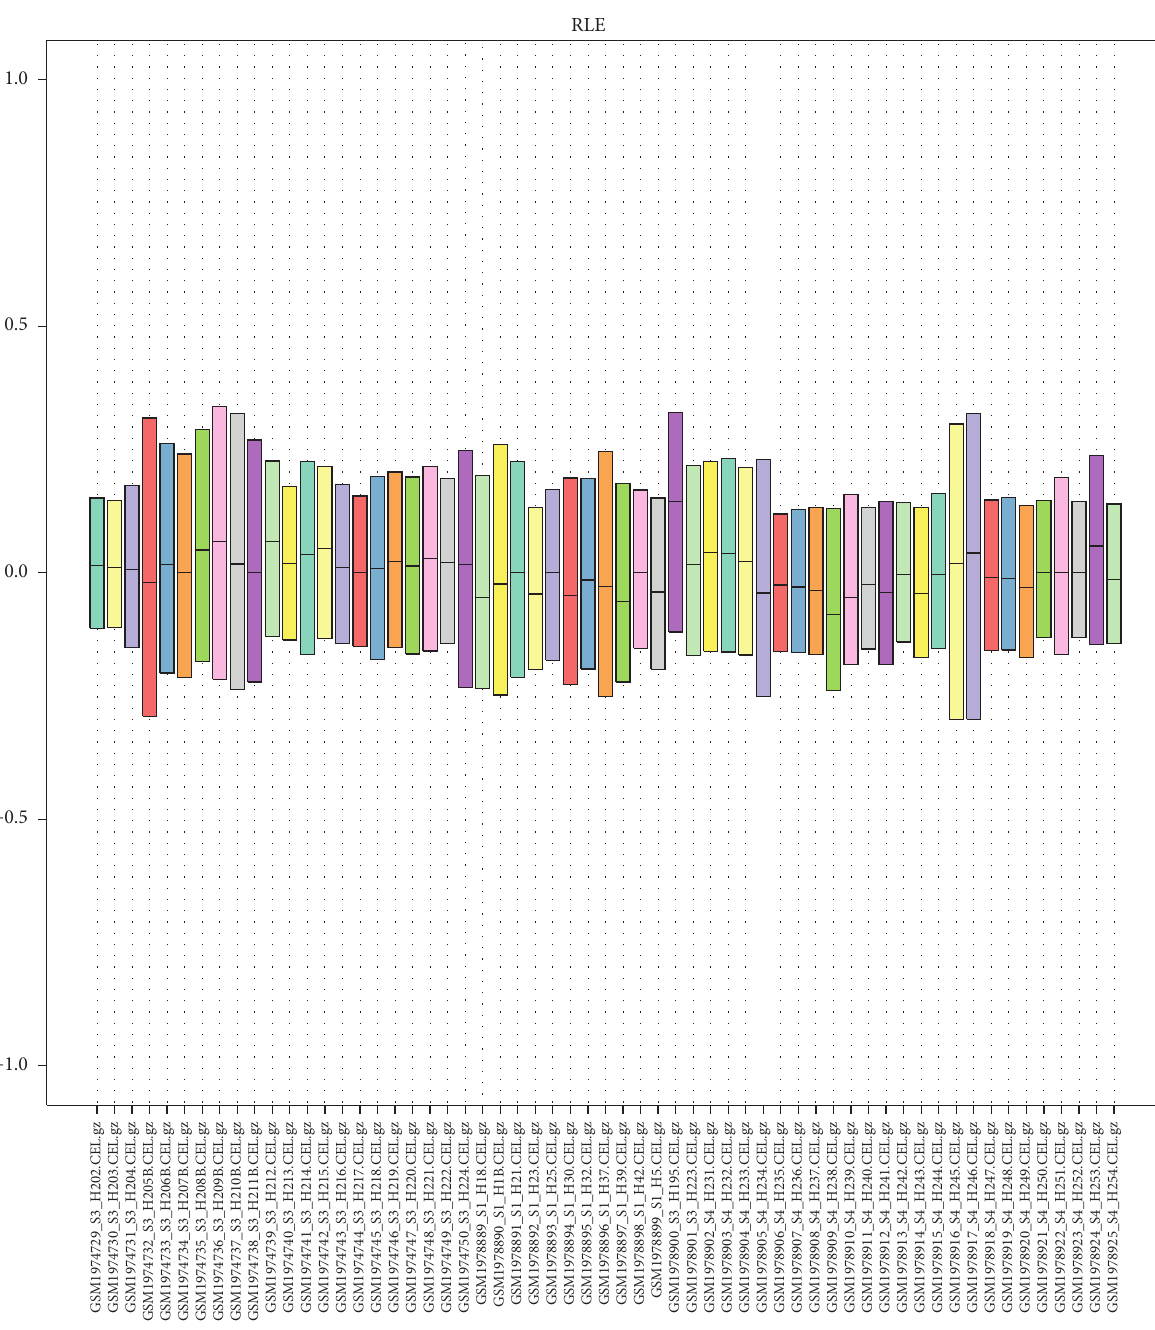
Figure 2: RLE box